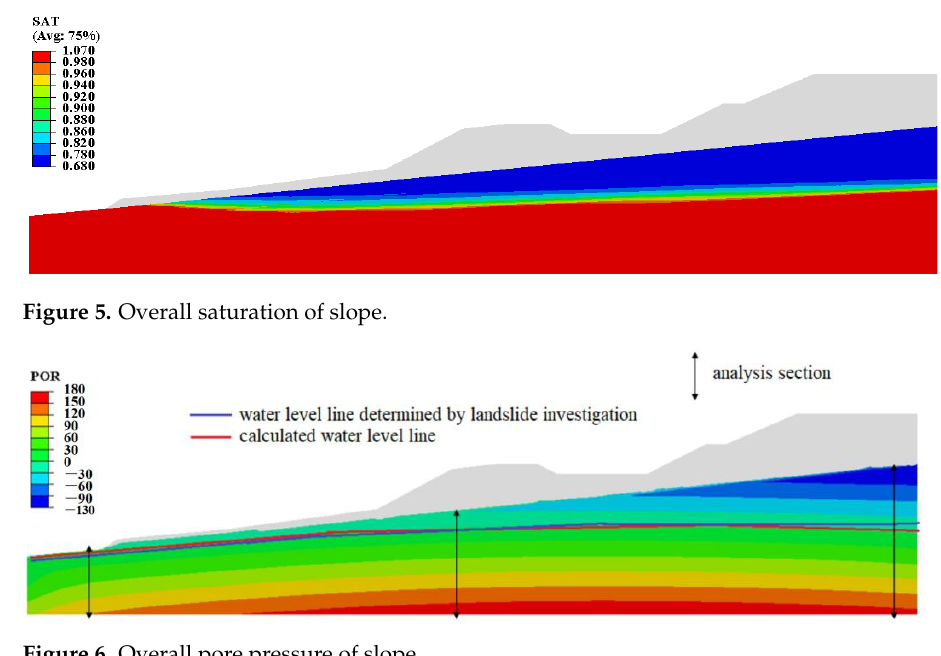
Figure 8. Vertical displacement of slope. (3) Site landslide analysis After the vertical tension cracks appear on the top of the embankment, ZK1–ZK9 ob- servation points are set on the site (Figure 9), which are respectively arranged at the upper, middle, and lower positions of the landslide for monitoring the vertical displacement of the slope. The settlement displacement of representative slope displacement monitoring points ZK2 (top of slope), ZK5 and ZK6 (middle of slope), as well as ZK8 (toe of slope) is shown in the following Figure 10. With the expansion of vertical cracks, the settlement increases rapidly in the initial stage and gradually stabilized in the later stage. The moni- toring data was stopped after the 15th. According to the monitoring results, the settlement value of the rear edge of the landslide is large, while the change of the front edge is not obvious. Figure 9. Scope of landslide.